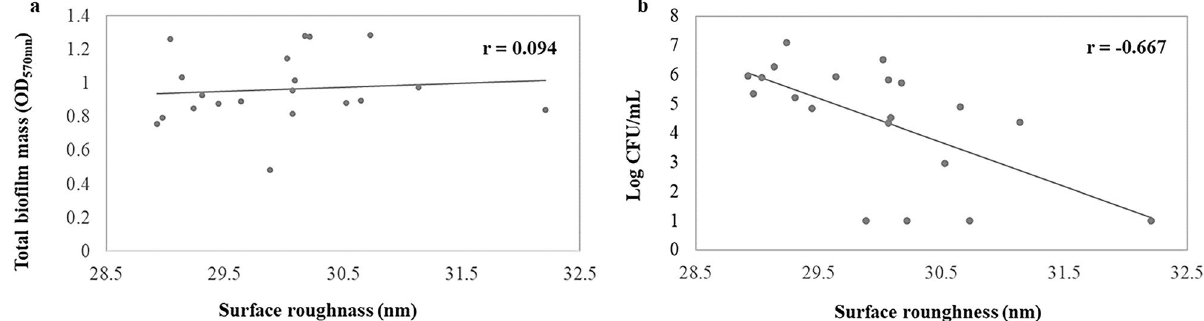
Figure 7. Statistical correlation between ( a ) The surface roughness and the total biofilm mass and ( b ) The surface roughness and log CFU/mL. Each data point represents the material surface roughness value (x-axis) and the biofilm mass amount or CFU (y-axis) on the coated NiTi alloy